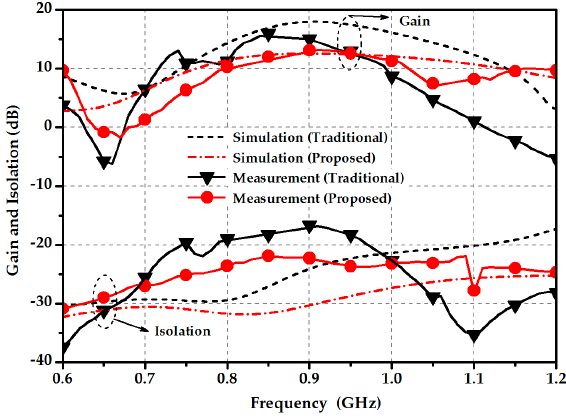
Figure 9. Simulated and measured gain and isolation.